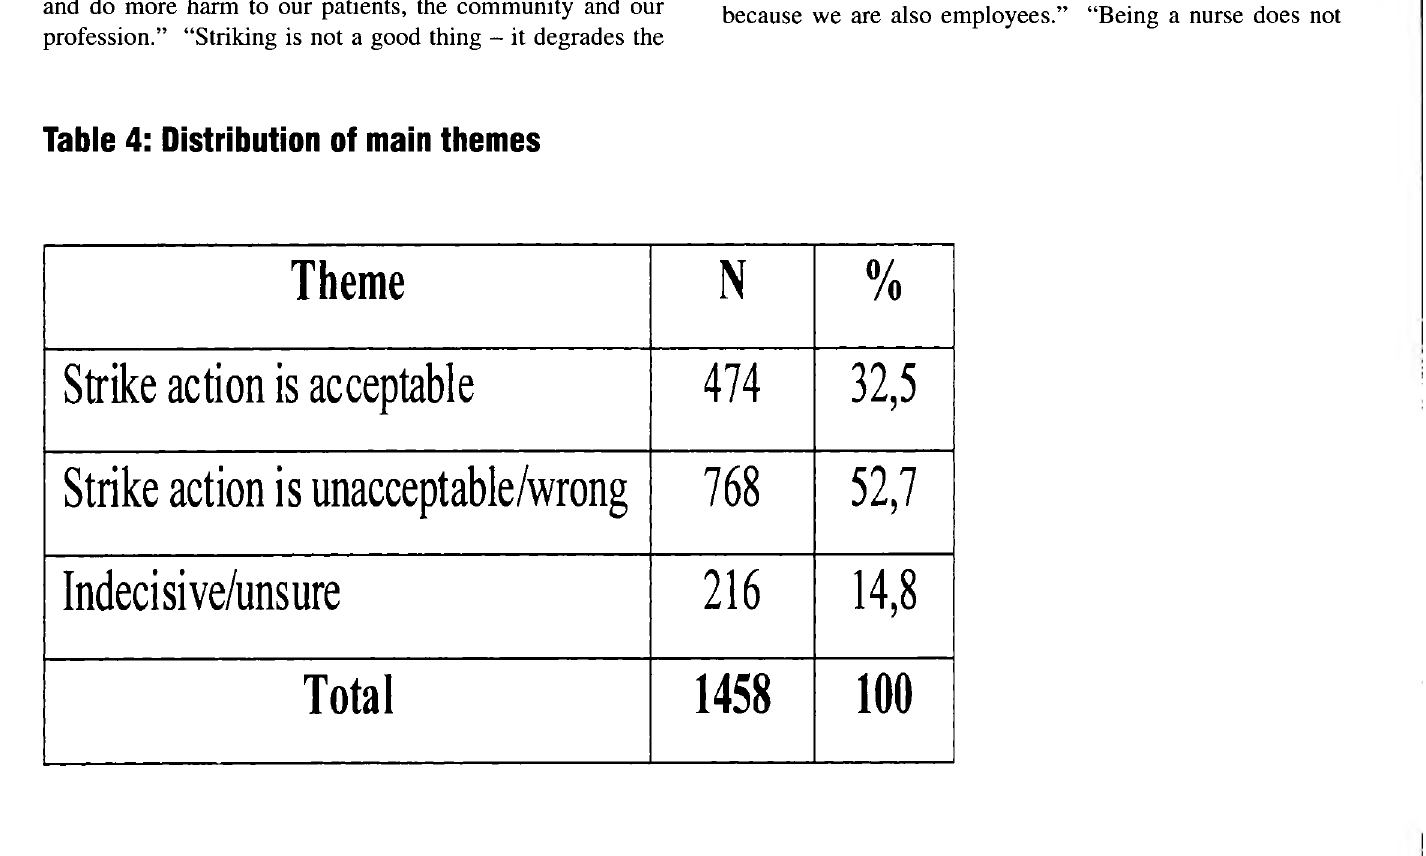
Table 4: Distribution of main